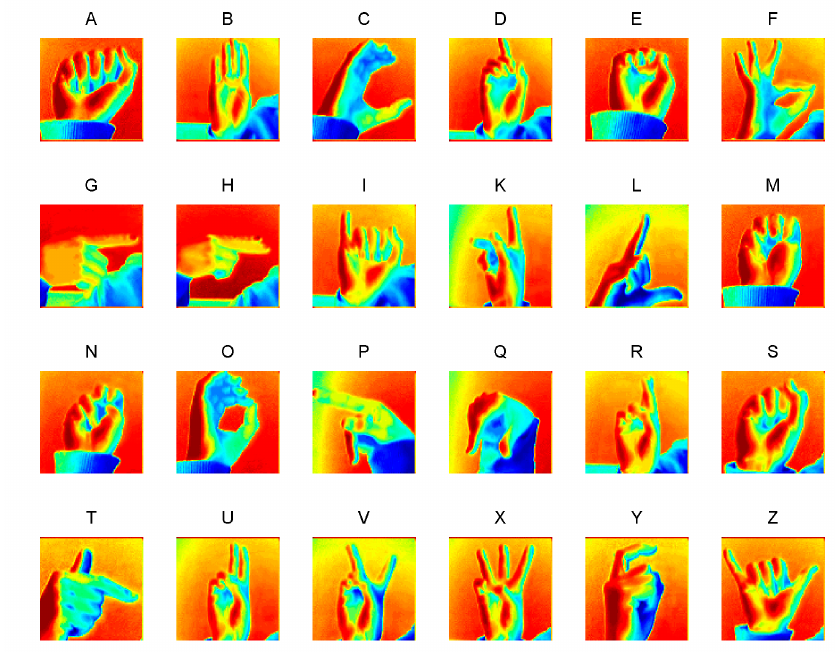
Figure 5. Alphabet Gestures for American Sign Language Alphabet.